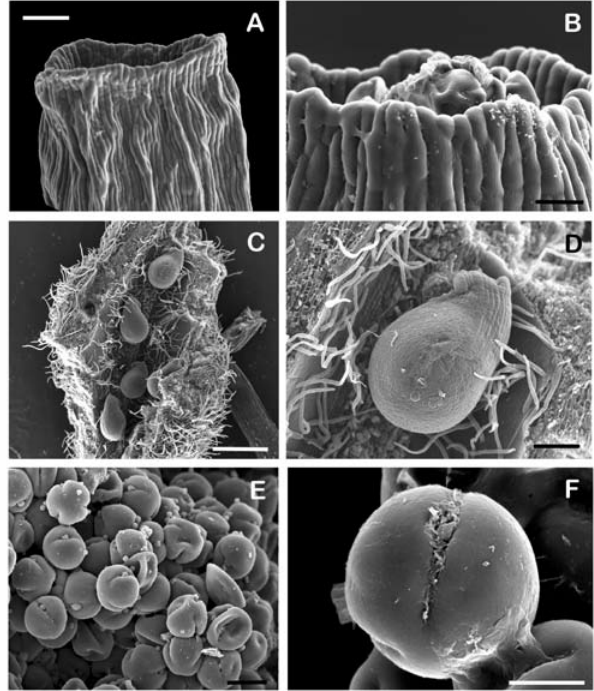
Fig. 6 - SEM micrographs of Moringa oleifera Lam pistil. A-B, style and stigma; B, detail of the stigma with pollen grain; C, ovarian cavity with ovules; D, detail of an ovule; E-F, pollen grains. Bars = A, 50 µm; B, E, 20 µm; C, 500 µm; D, 100 µm; F, 10